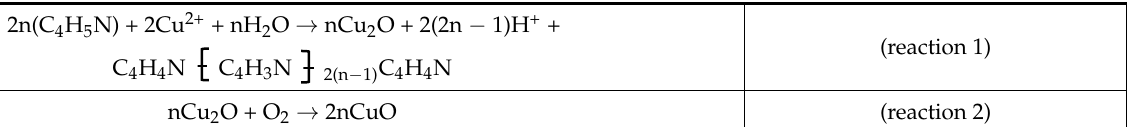
Figure 1. Illustration of the morphology changes as a result of the processing time and pyrrole concentration variations during the hydrothermal process of copper acetate.